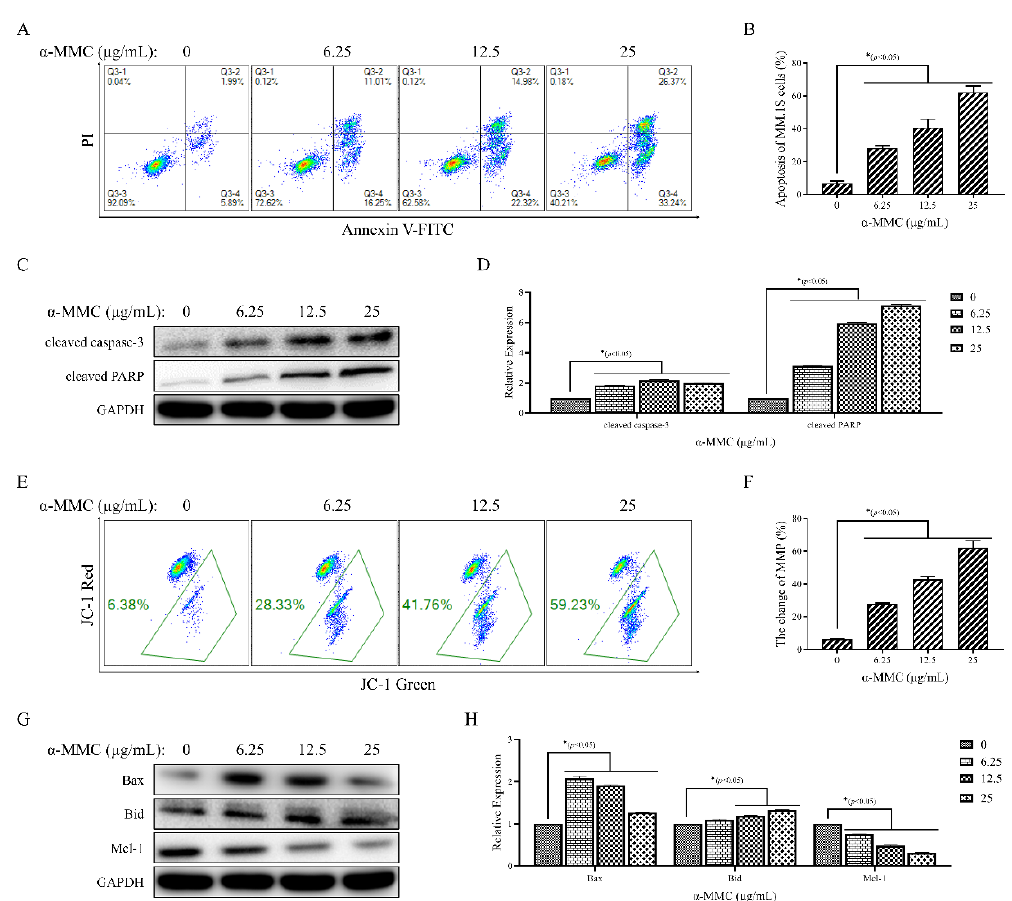
Figure 4. Effect of α -MMC on apoptosis of MM.1S cells. After being treated with α -MMC for 24 h, 5000 counts of MM.1S cells stained with annexin V-FITC/PI ( A ) and JC-1 fluorescence probe ( E ) were collected using FCM, and then the effects of α -MMC on MM.1S cells’ apoptosis and MMP were analyzed. Western blot was used to detect the expression levels of apoptosis-related proteins at the protein level ( C , G ). GraphPad Prism 9.0 software was used to draw a histogram to reflect the percentage of apoptosis, the change rate of MMP, and the relative expression levels of proteins ( B , D , F , H ). In the experimental group (6.25, 12.5, 25 μg/mL α -MMC group) comparisons with the control group (0 μg/mL α -MMC group), * p < 0.05 was considered to be statistically significant.